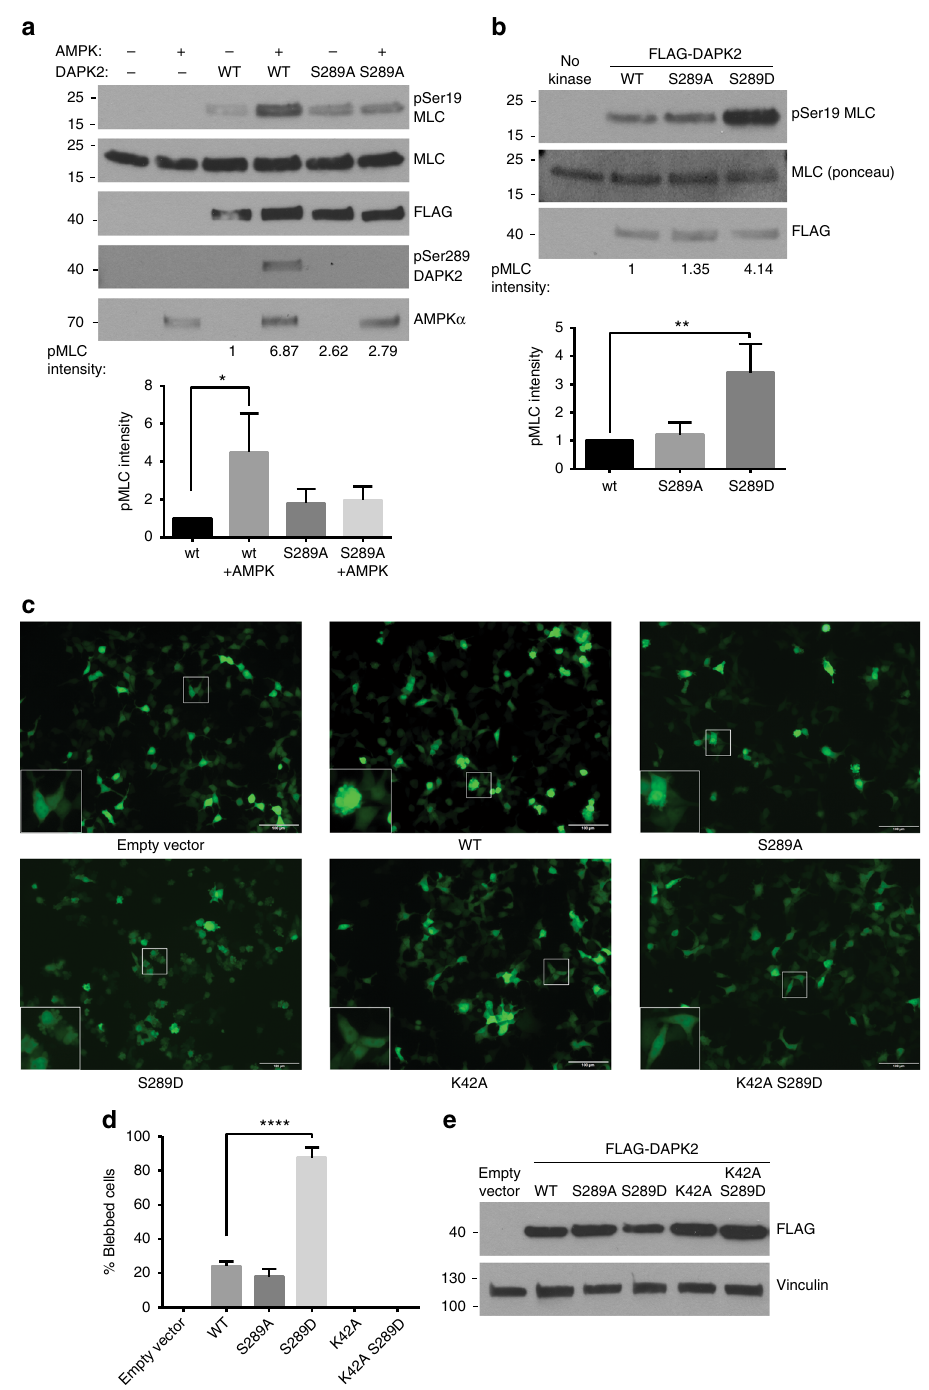
Fig. 3 Ser289 phosphorylation enhances DAPK2 ’ s catalytic activity. a Sequential kinase assays of AMPK on FLAG-DAPK2 in AMPK kinase buffer, and then of DAPK2 on MLC in DAPK2 kinase assay buffer. Phosphorylation was assessed by western blotting of the reaction mixtures. Bar graph represents pMLC intensity as mean ± SD of three independent repeats. Statistical analyses were performed using one-way ANOVA with post hoc Dunnett ’ s multiple comparison test. * P < 0.05. b FLAG-DAPK2 WT, S289A or S289D was incubated in a kinase reaction mixture with MLC, and phosphorylation assessed by western blotting of the reaction mixtures. pMLC band intensity was quanti fi ed using NIH ImageJ software. Bar graph represents pMLC intensity as mean ± SD of three independent repeats. Statistical analyses were performed using one-way ANOVA with post hoc Dunnett ’ s multiple comparison test. ** P < 0.01. c HEK293T cells were transfected with GFP and the indicated constructs, and imaged after 24 h. Scale bar = 100 µ m. d Quanti fi cation of the extent of blebbing among GFP-positive cells. Bar graph represents percent of blebbed cells as mean ± SD of three independent repeats. Statistical analyses were performed using one-way ANOVA with post hoc Dunnett ’ s multiple comparison test. **** P < 0.0001. e Western blot of a representative experiment from